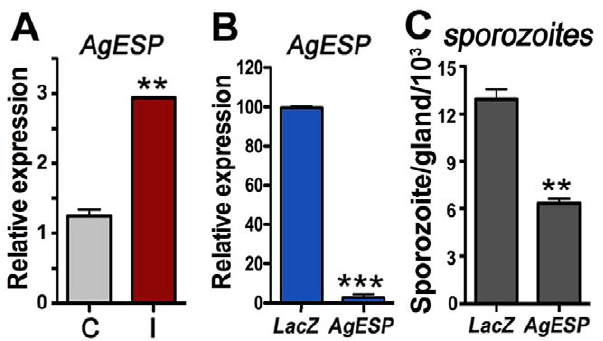
Figure 6. AgESP expression and effect of silencing on Plasmodium berghei salivary gland (SG) infection. (A) AgESP mRNA levels in SGs of mosquitoes fed on a healthy mouse (C, control; grey bars) or a P. berghei- infected mouse (I, infected; red bars) 18 days post feeding (PF). (B) Effect of AgESP dsRNA injection on AgESP expression (blue bars). Infected mosquitoes were injected with dsRNA 14 days PF, and mRNA levels were determined 4 days later. (C) Effect of AgESP silencing on the number of P. berghei sporozoites present in the SGs (black bars) 21 days PF. The unpaired two-tailed t -test was used to compare the different experimental groups (**, P , 0.01; ***, P , 0.001). All expression analysis was confirmed in 2–3 independent biological replicates. Infection phenotypes were confirmed in 2–3